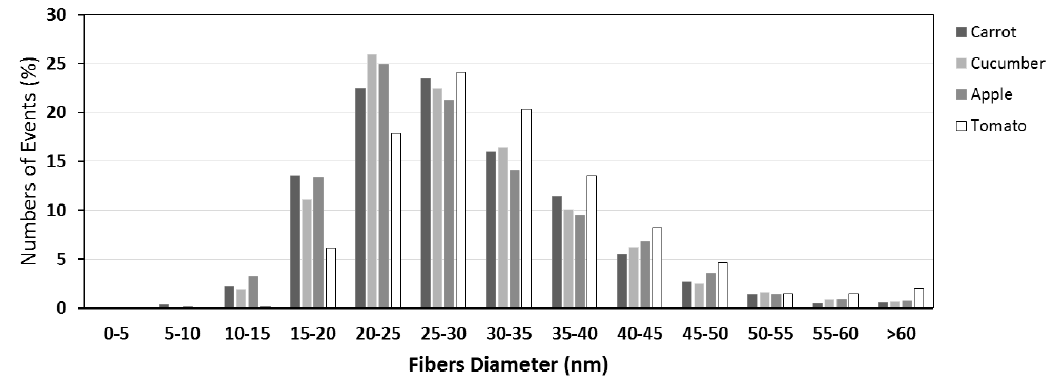
Figure 4. Histograms of cellulose microfibrils diameter distribution of cellulose isolated from apple, carrot, cucumber, and tomato pomaces.